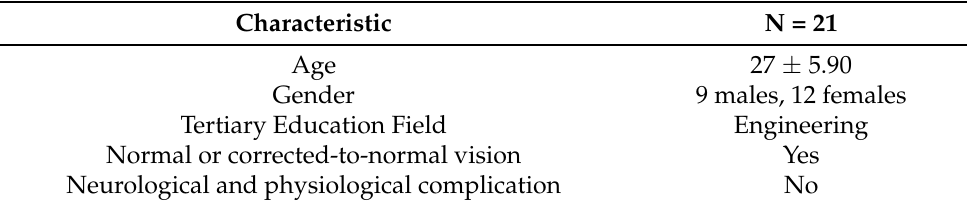
Table 3. Characteristics of